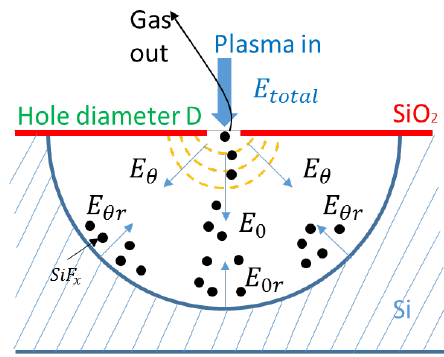
Figure 6. The schematic of the reaction in a microhole.